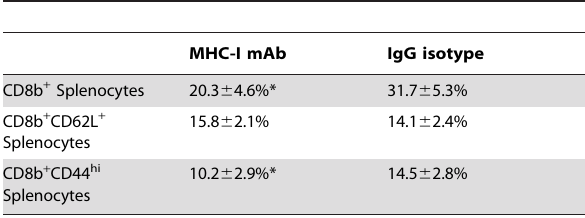
Table 3. Effect of MHC-I mAb treatment on CD8 + T cells of recipient mouse